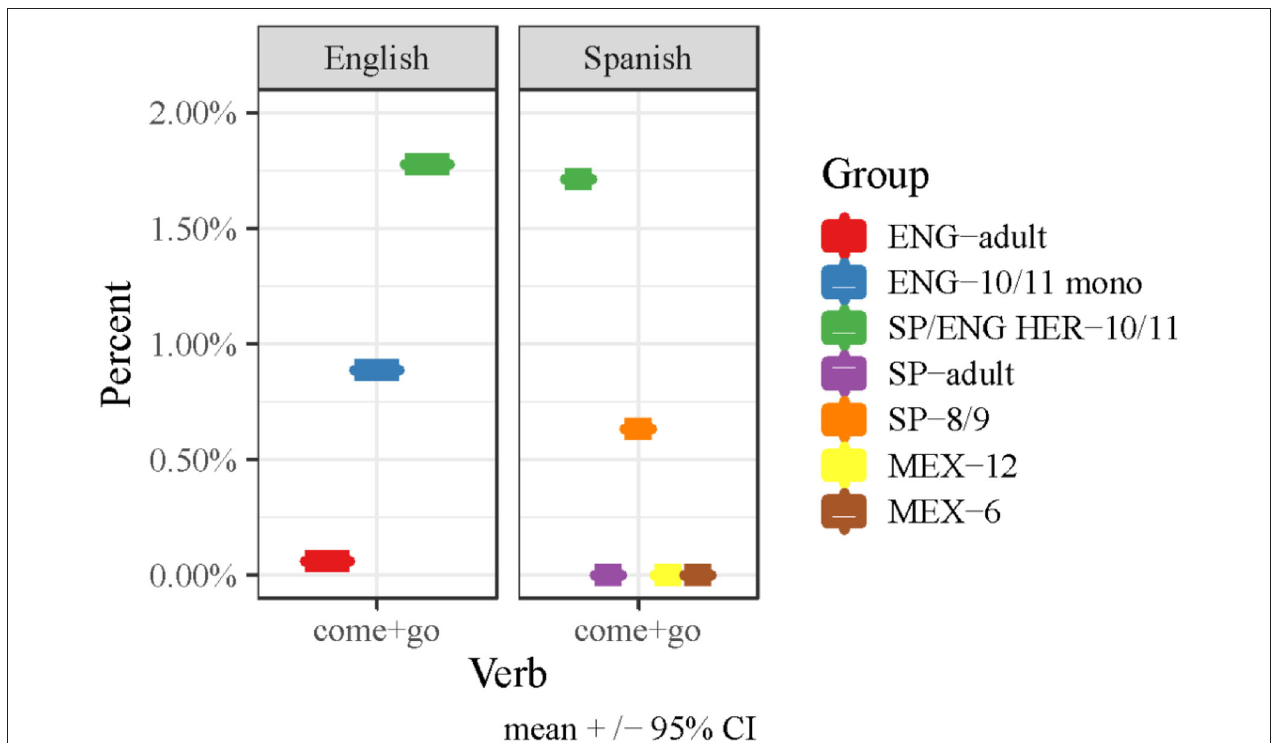
FIGURE 1 | Percentage of use of the verbs “come” (as come or venir ) and “go” (as go or ir ) out of all 1,576 verbs produced in all coded scenes.